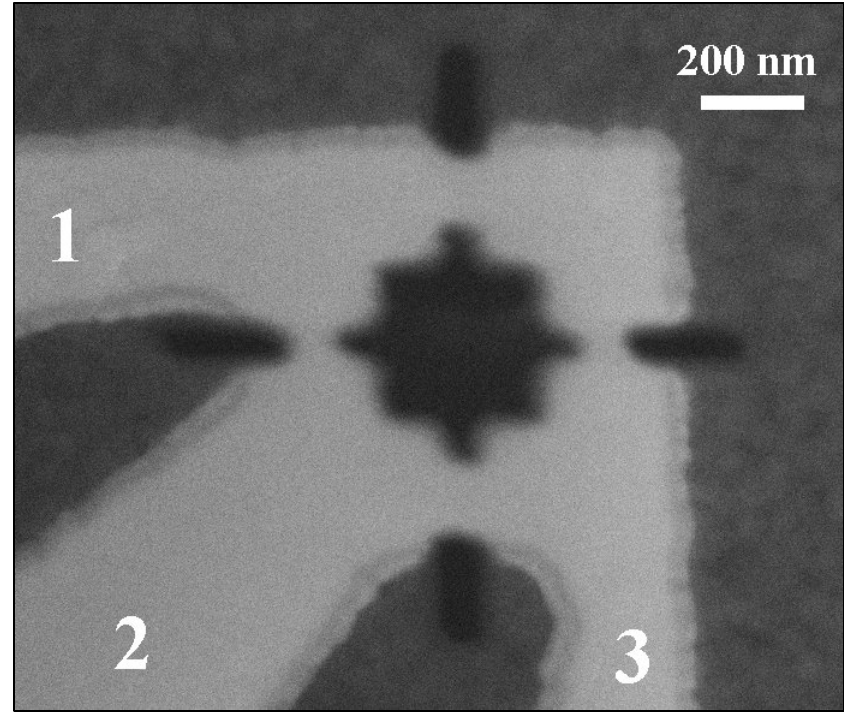
Figure 4. SEM image of a nanoSQUID fabricated using FIB etching with four ∼ 50-nm-long nJJs, a 300 nm × 300 nm hole and 3 current leads, in accordance with the schematic diagram shown in Figure 1.